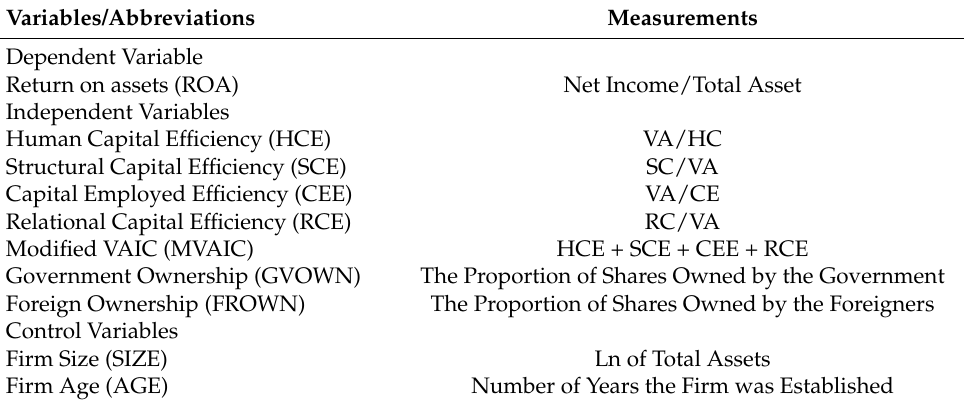
Table 2. Variable